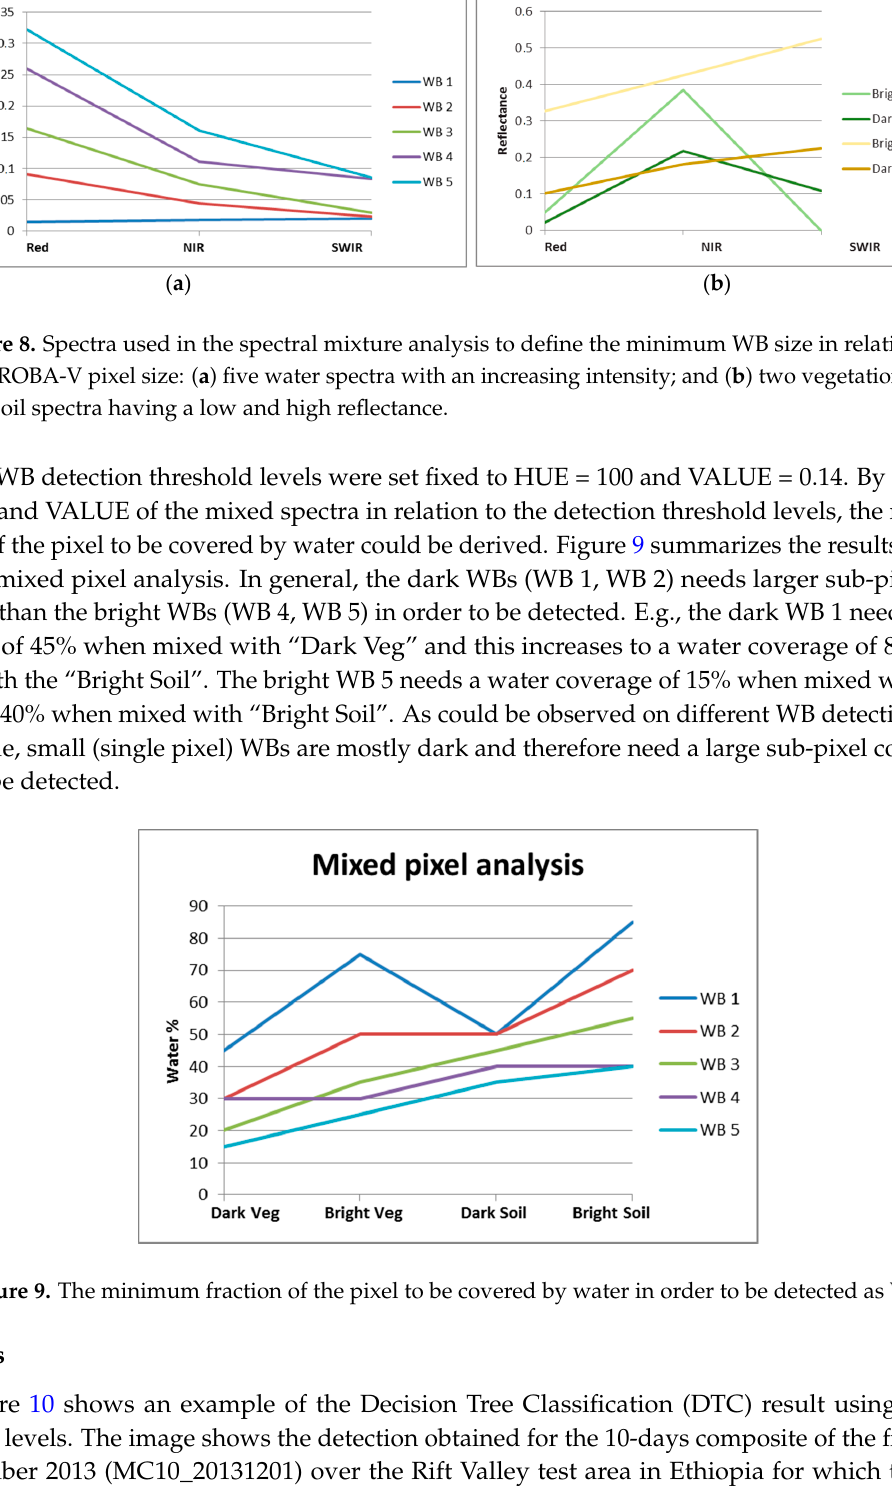
11 of 25 Figure 7. Example of a 2D scatter plot of the WB frequency ( WBf ) and the number of continuous temporal WB observations ( mctWBs ). The plus symbols belong to pixels of detected WBs for the Rift Valley test area calculated for the 31 available dekads. The Water Body Occurrence threshold levels are indicated by the different colored areas. 2.6. Minimum Size of Detectable Water Bodies